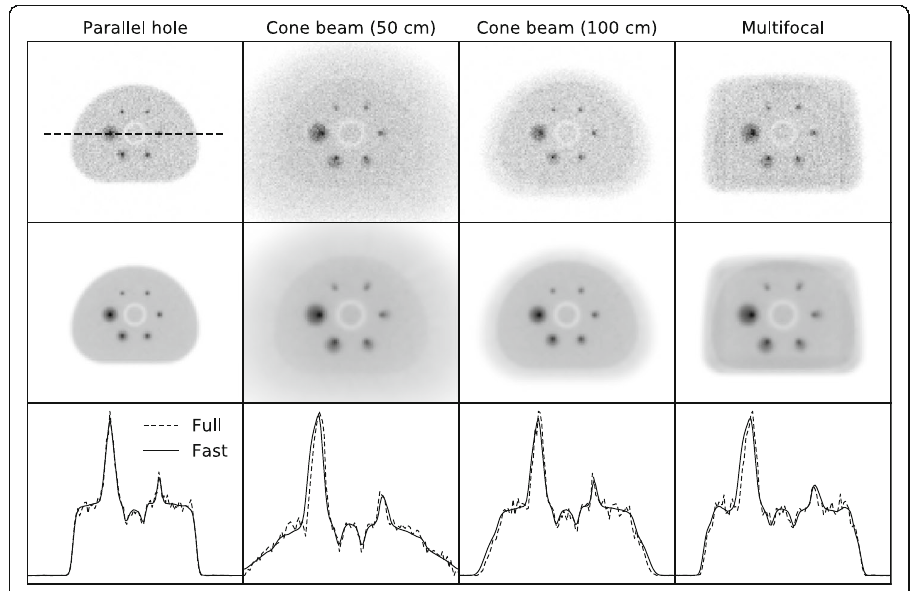
Fig. 5 Projections of the NEMA phantom made with the GATE Monte Carlo projector (top row) and with the fast Monte Carlo projector (middle row) for the parallel hole, cone beam (50 cm), cone beam (100 cm), and multifocal collimators. Profiles along the middle spheres are shown in the bottom row. The GATE Monte Carlo projections are generated with 2.6, 4.1, 2.7, and 2.6 billion photons,